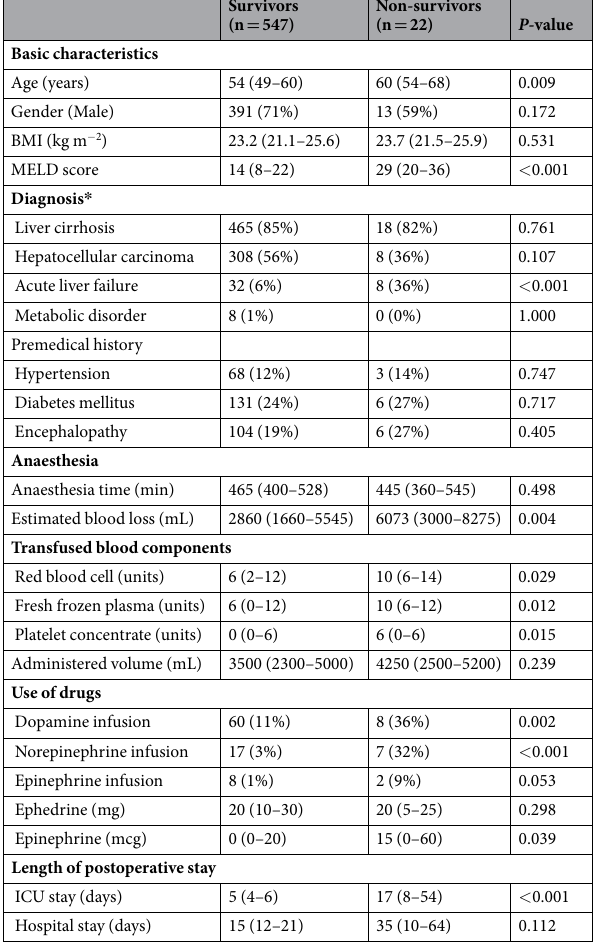
Table 1. Patient characteristics. Data are expressed as median (interquartile range) or numbers (%). Characteristics of two groups were compared with Pearson chi-square test or Fisher’s exact test and Mann- Whitney test. * The sum of diagnoses exceeds the number of patients in each group because a part of patients have complex disease entities. Abbreviations: ICU = intensive care unit; MELD = model for end-stage liver